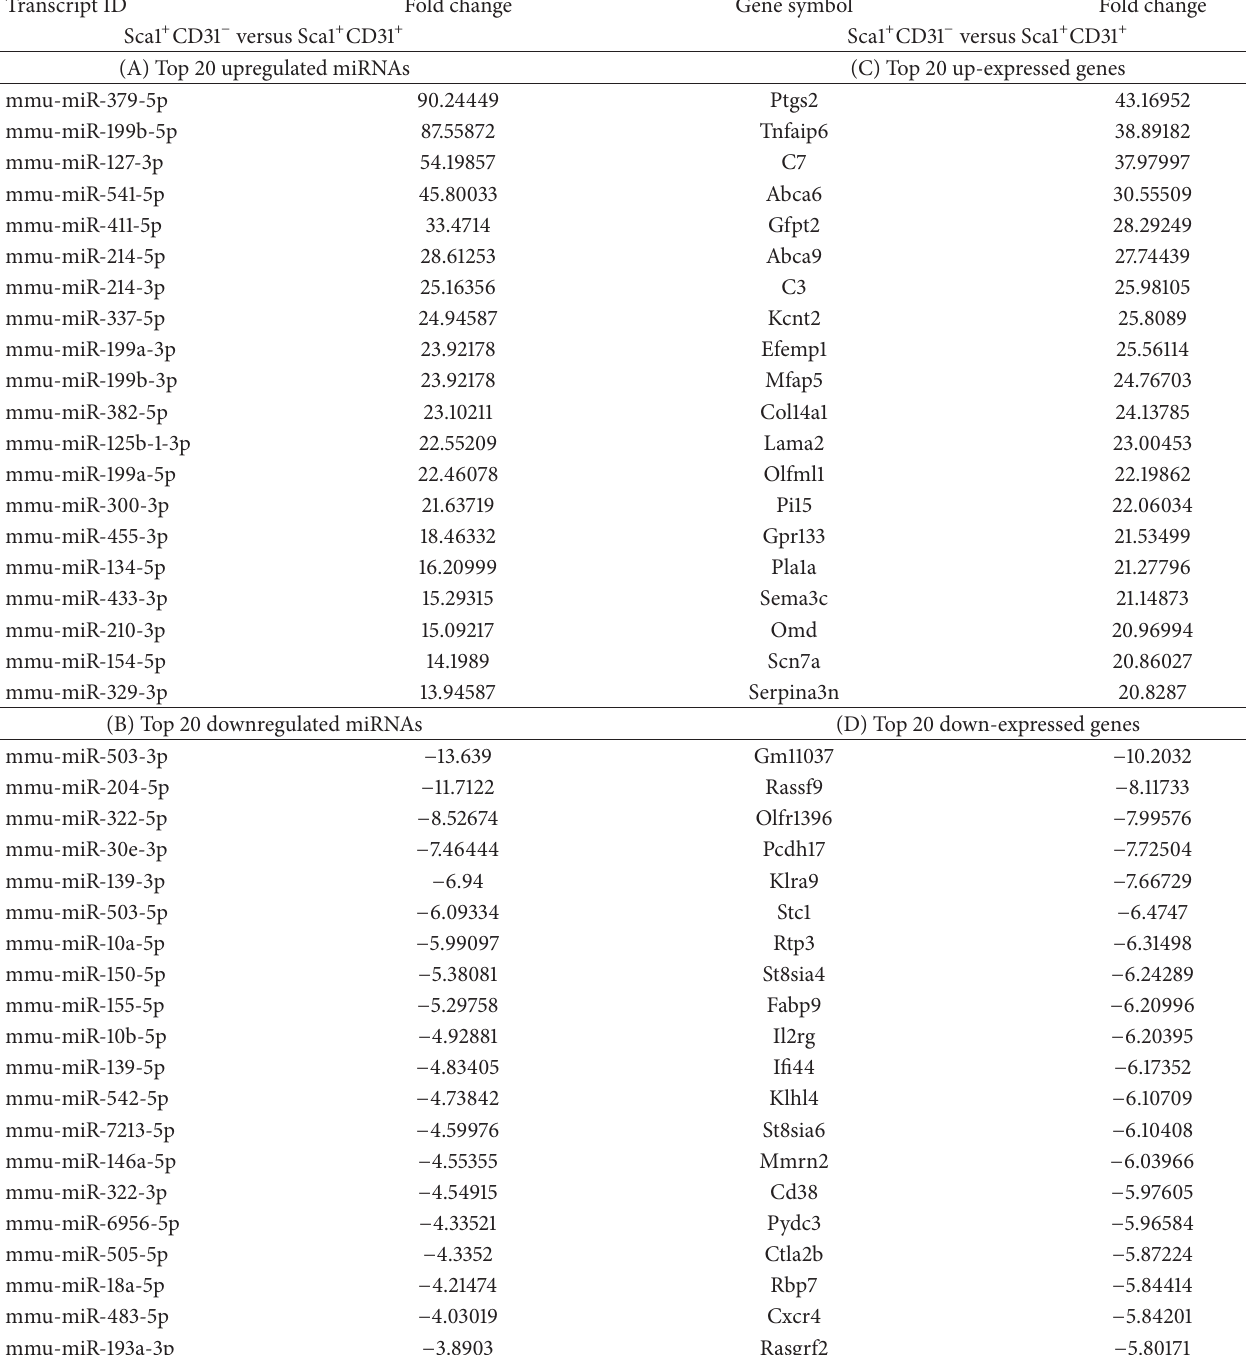
Table 2: Differentially expressed miRNAs and